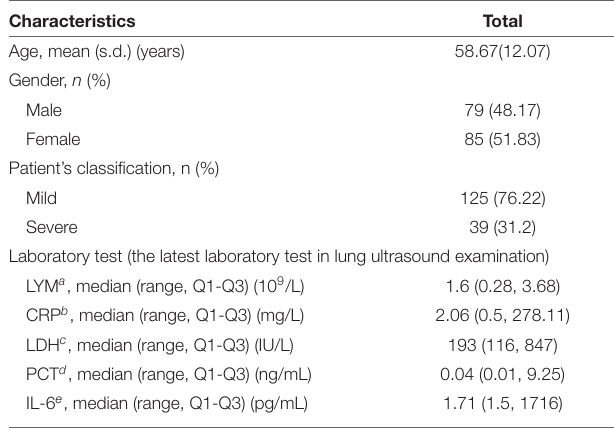
TABLE 1 | The clinical information related to coronavirus disease 2019 (COVID-19) patients.